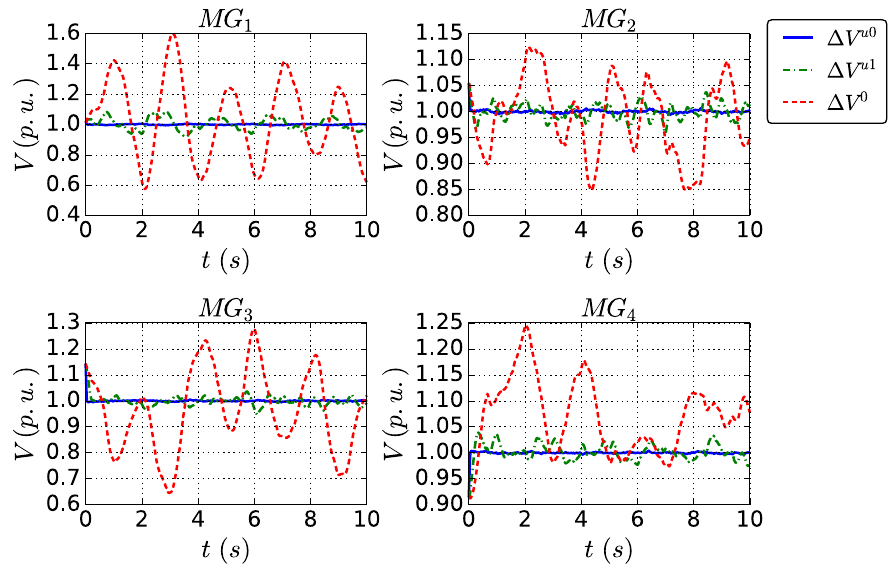
Figure 6. Voltage deviations in four microgrids (MGs).